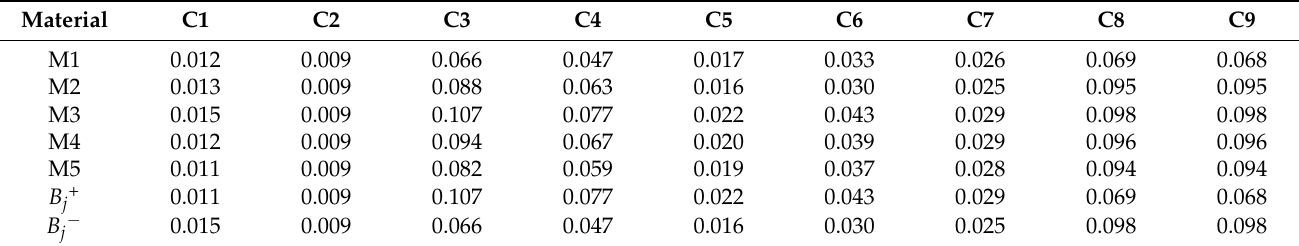
Table A6. TOPSIS normalized weighted